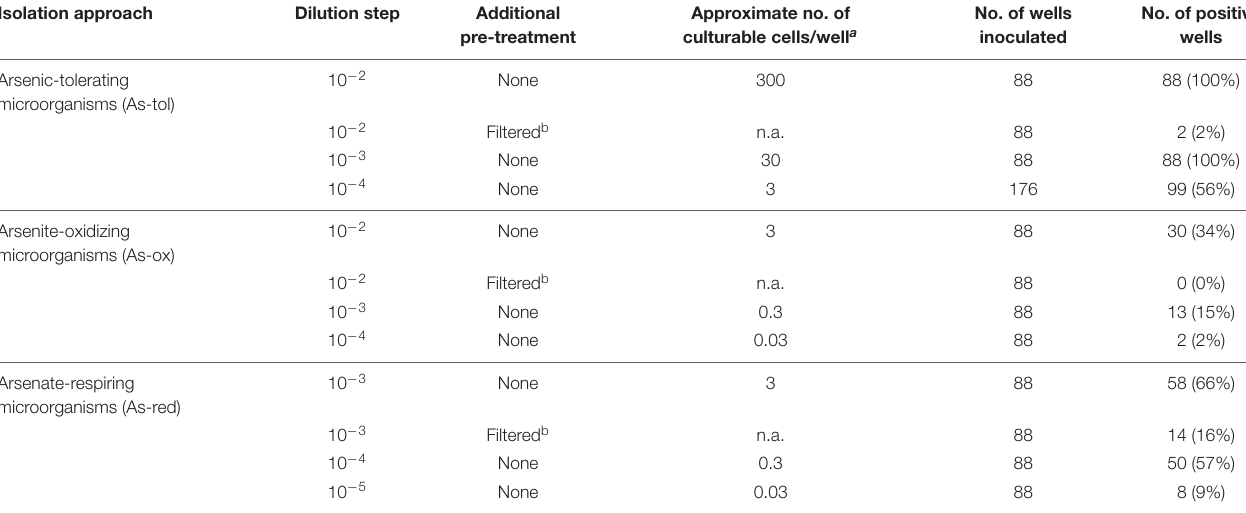
TABLE 1 | Setup of the dilution-to-extinction cultivation approaches and their success